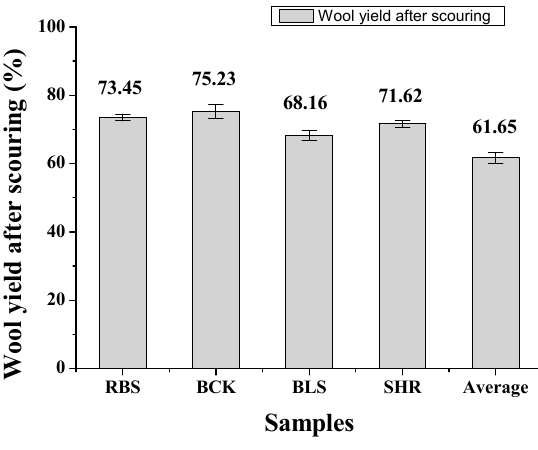
Figure 5. Wool yield percentages after scouring.